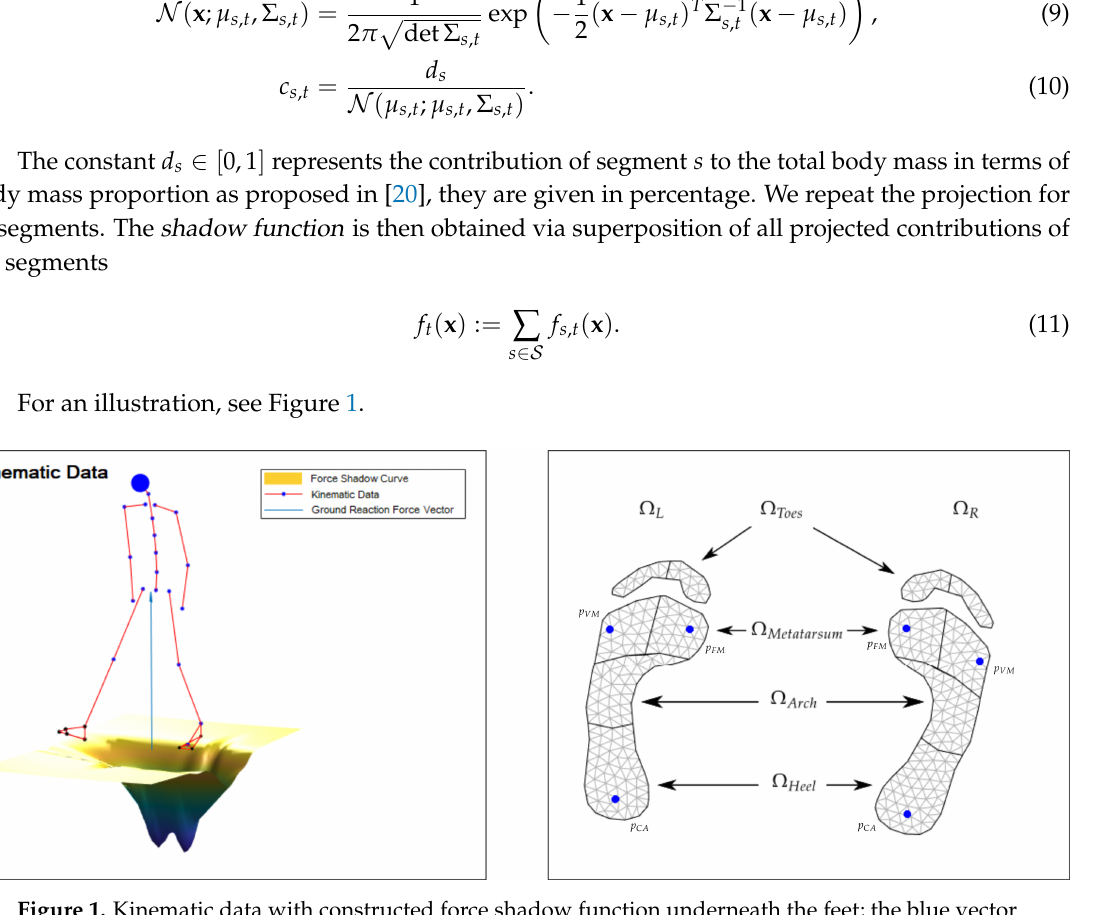
Figure 1. Kinematic data with constructed force shadow function underneath the feet; the blue vector describes the ground reaction force F GRF ( left plot ). Standard foot model for the left and right foot with partitioned regions Ω i ( right plot ); the location of the first- ( p FM ) and the fifth metatarsal head ( p VM ) and the calcaneus bone ( p CA ) are marked as blue